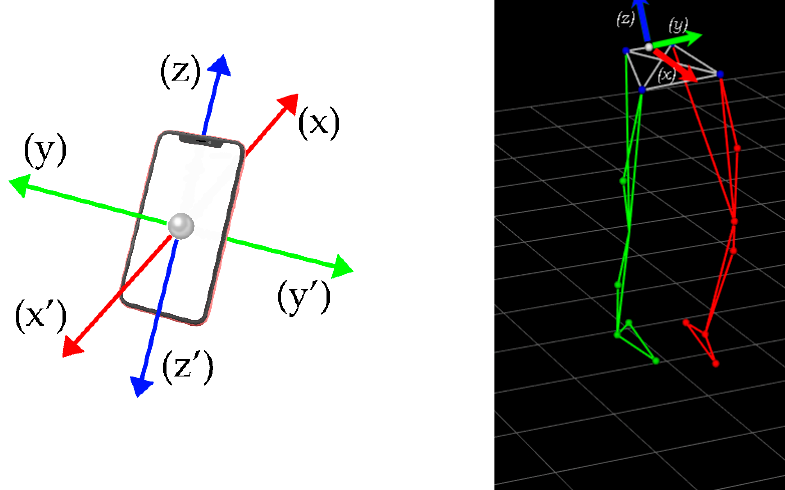
Figure 5. Smartphones and average market orientation